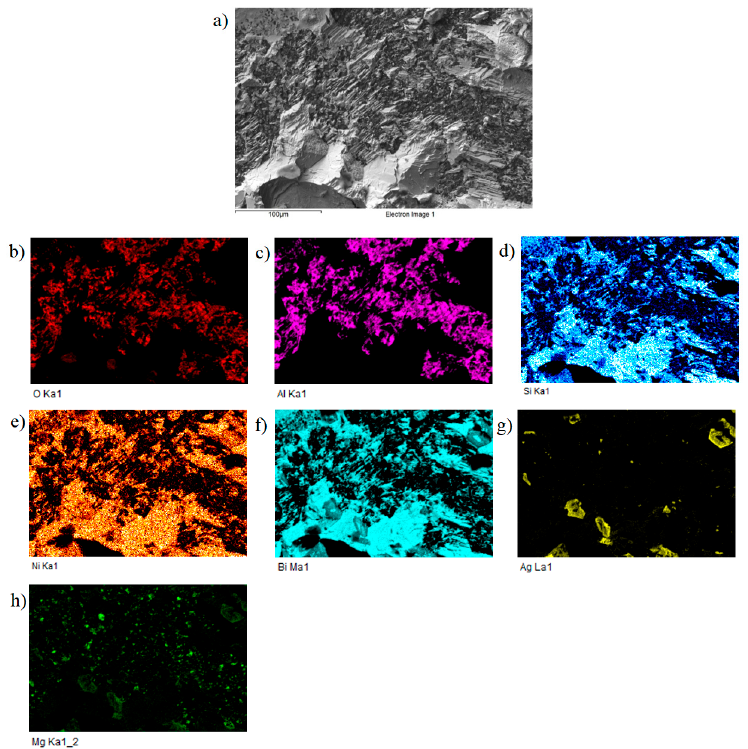
Figure 21. Fractured surface of the soldered joint of Al 2 O 3 /Bi11Ag1Mg/Ni–SiC and the planar distribution of individual elements: ( a ) fracture morphology; ( b ) O; ( c ) Al; ( d ) Si; ( e ) Ni; ( f ) Bi; ( g ) Ag; and ( h )